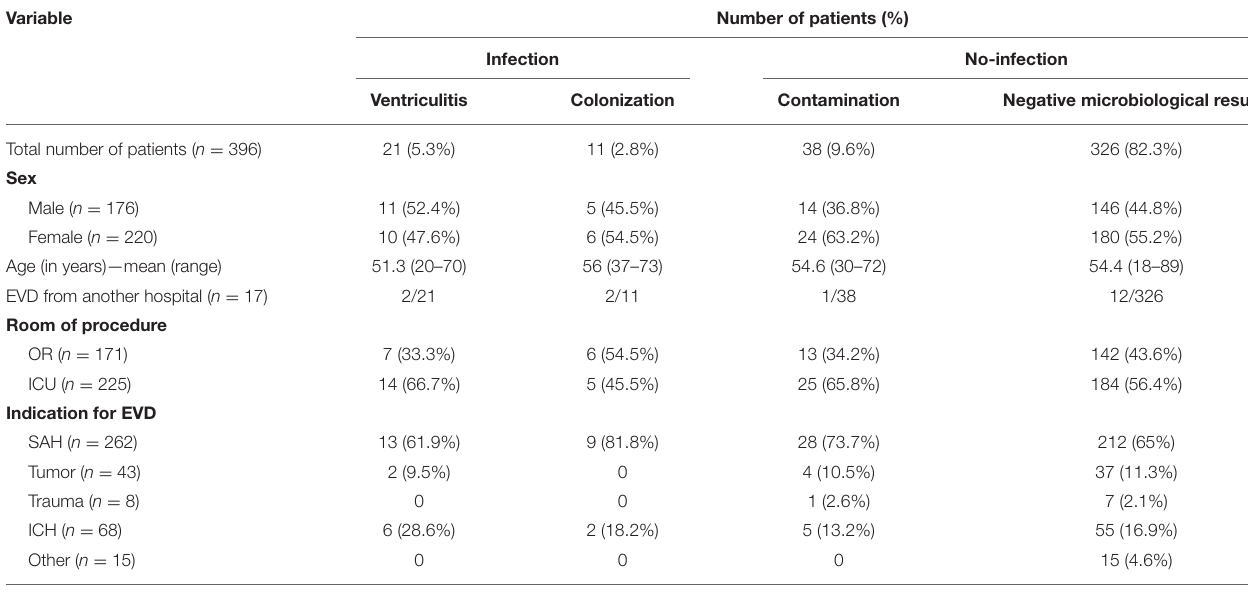
TABLE 4 | Characteristics of the study patients. Variable Number of patients (%) Infection No-infection Ventriculitis Colonization Contamination Negative microbiological